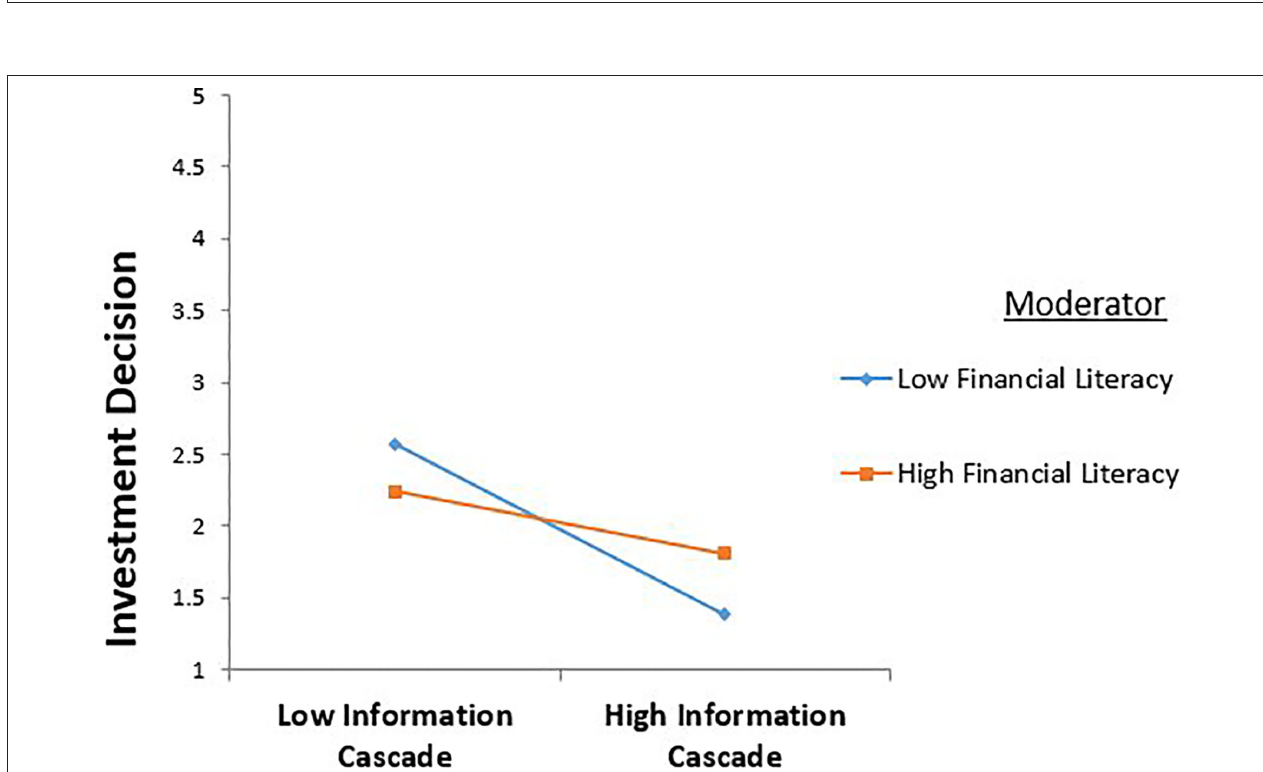
FIGURE 3 | Moderating role of financial literacy between information cascade and investment decision.